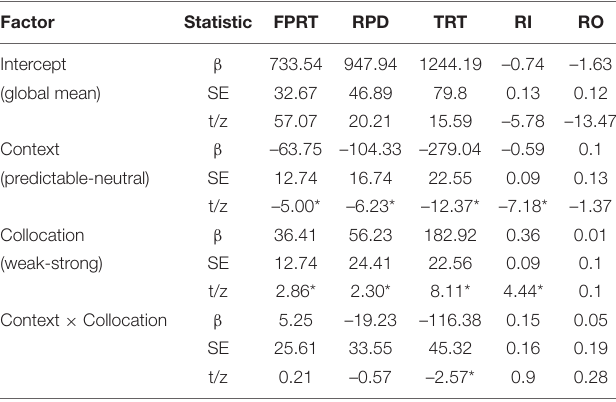
TABLE 2 | Summary statistics for the collocation.